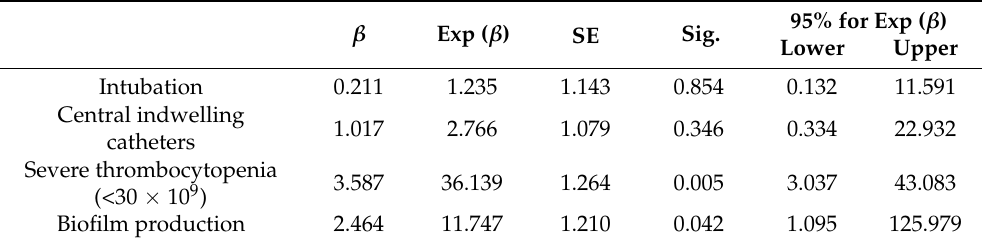
Table 5. Binary logistic regression analysis assessing parameters that might predict the risk of persistent CoNS bacteremia the period